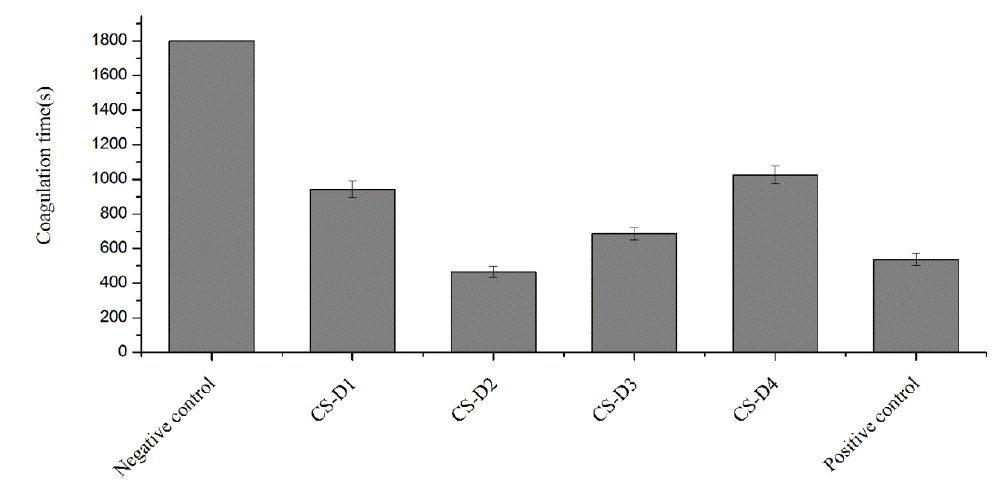
Figure 3. Effect of DD of chitosan on coagulation time.